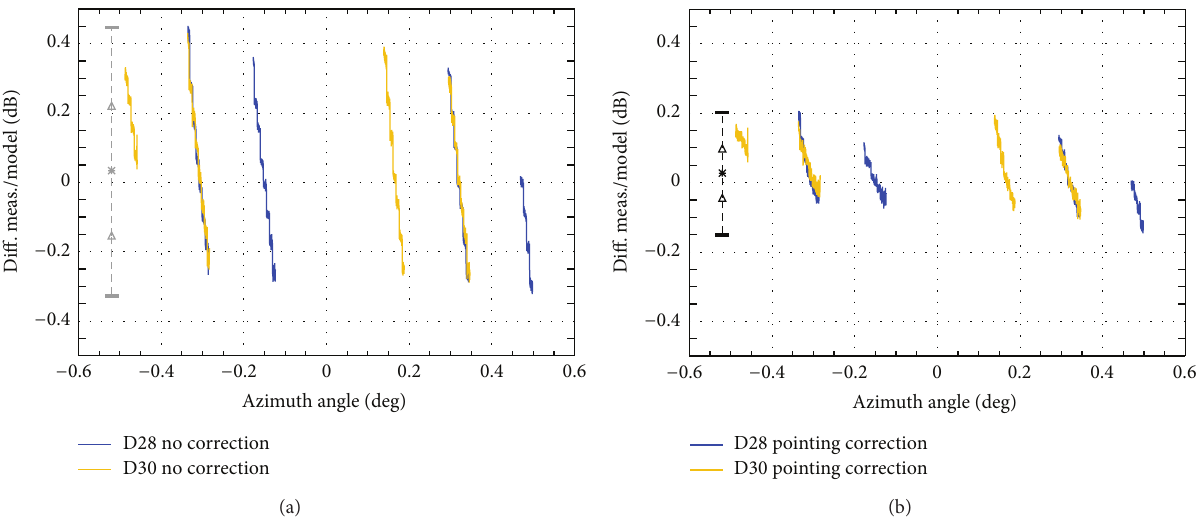
Figure 5: Difference between measurement on March 24, 2012, and model for the 3db region of the TOPS azimuth patterns, statistical values: grey/black. (a) Without pointing correction, (b) with pointing